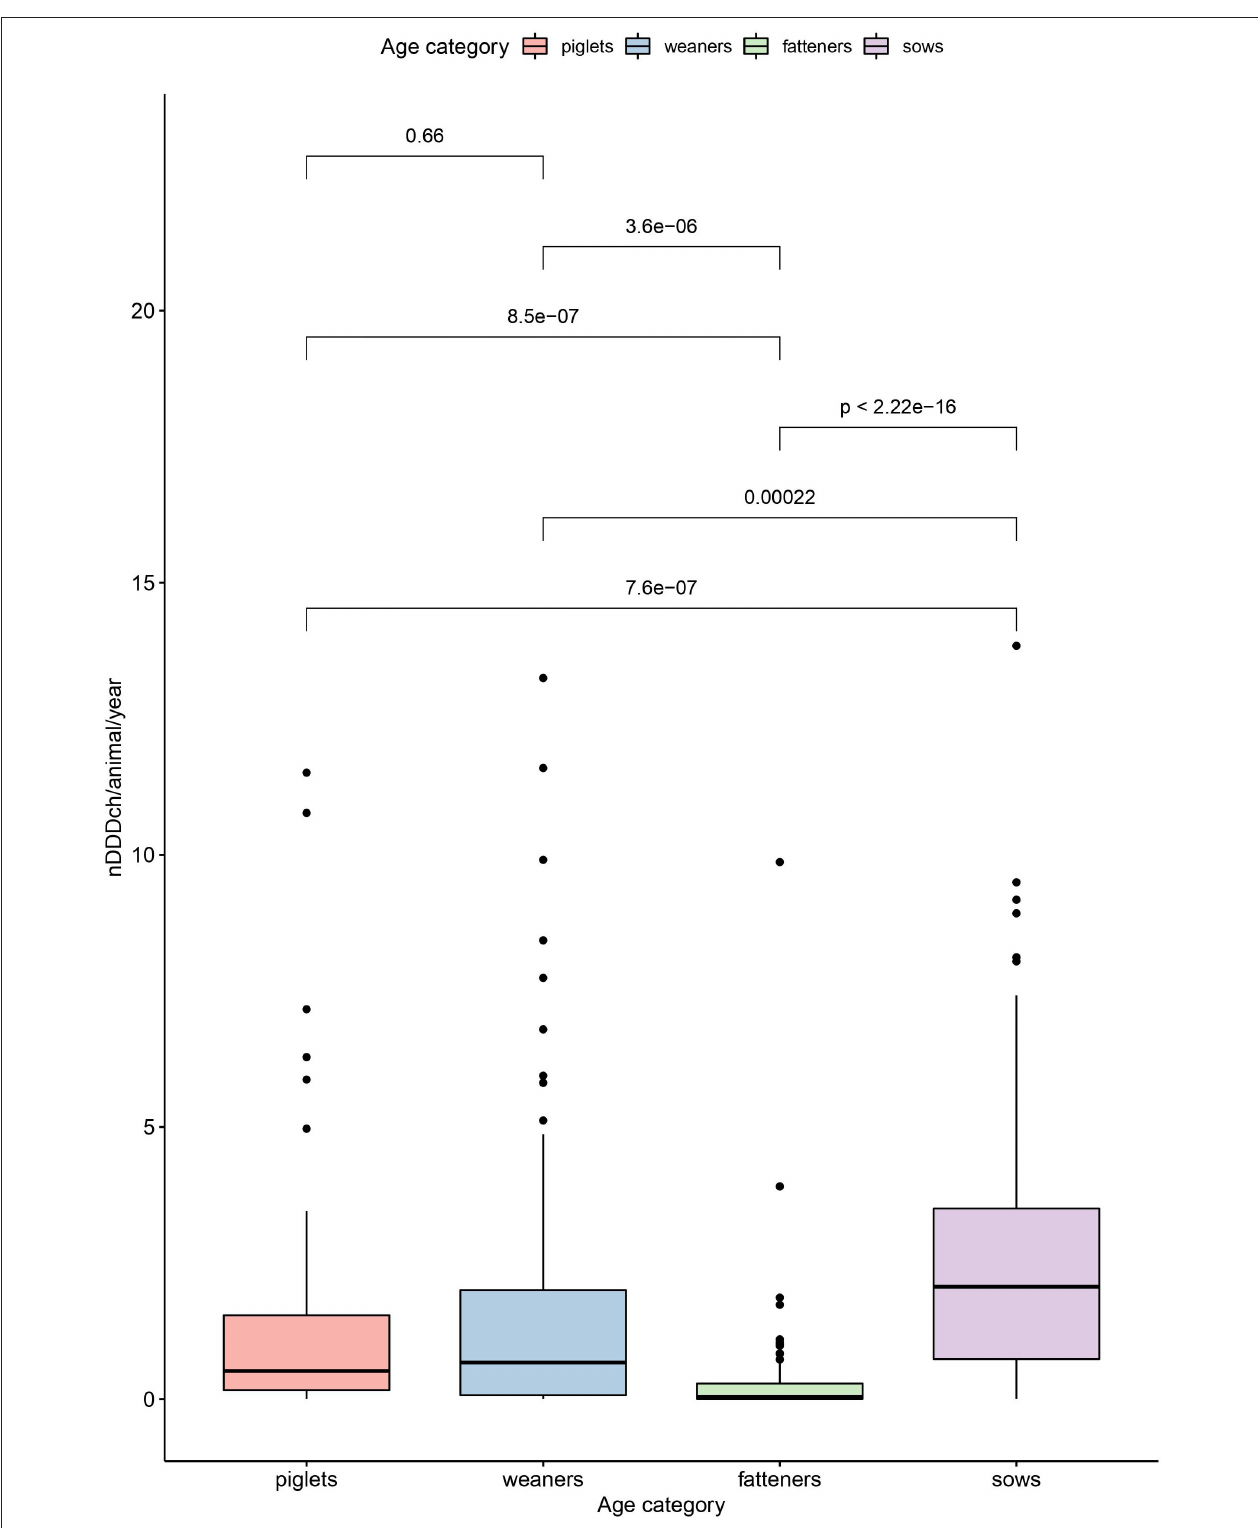
FIGURE 2 | Boxplot showing differences in the number of defined daily doses Switzerland per pig (nDDDch/animal/year) among the individual age categories (piglets, weaners, fatteners, and sows) investigated by a Kruskal-Wallis test followed by a post hoc pairwise analysis (Bonferroni correction).